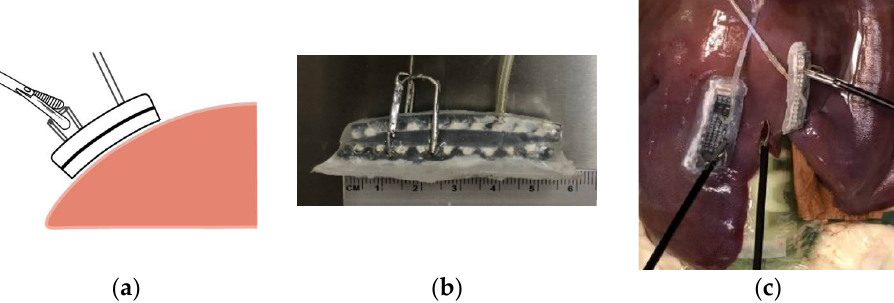
Figure 1. Tunable stiffness organ-grasping device in a previous work [13]. ( a ) Concept. ( b ) Prototype. ( c ) Experimental scene with porcine liver.